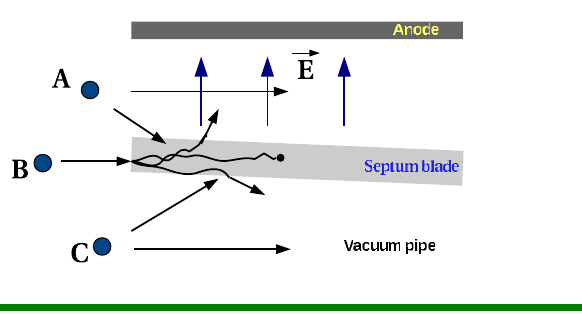
FIG. 12. Sketch of all possible cases when a particle reaches the